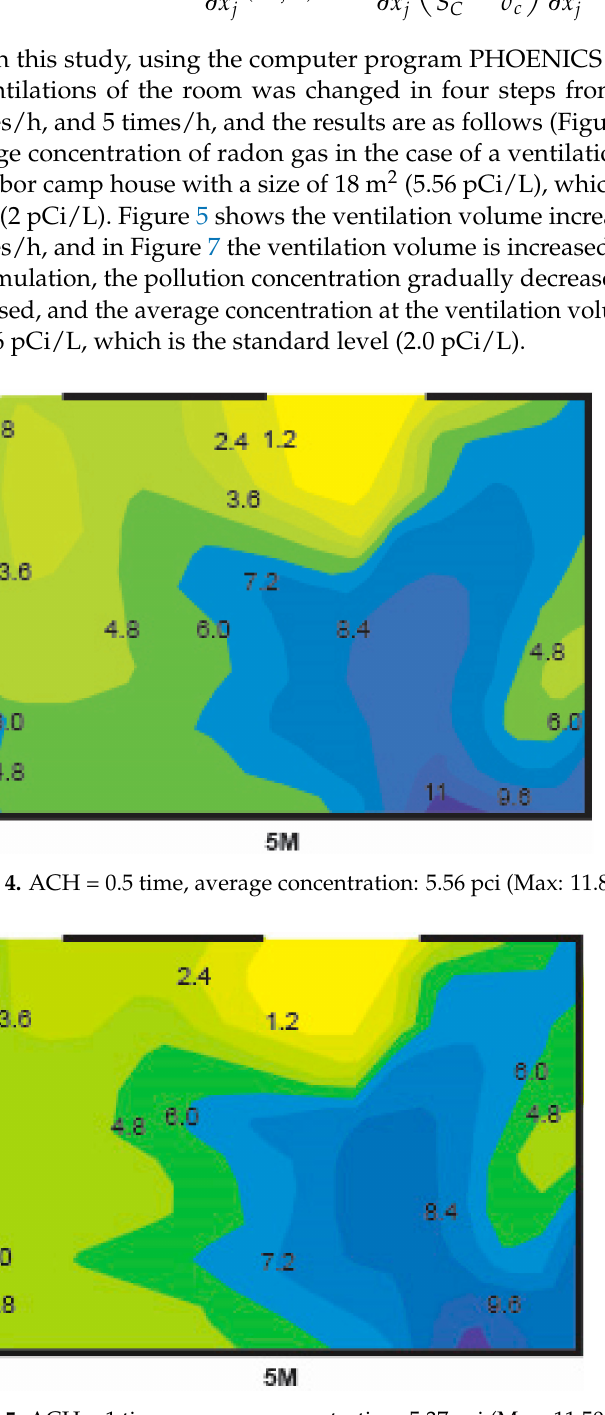
Figure 5. ACH = 1 time, average concentration: 5.37 pci (Max: 11.50 pci, Min: 0.30